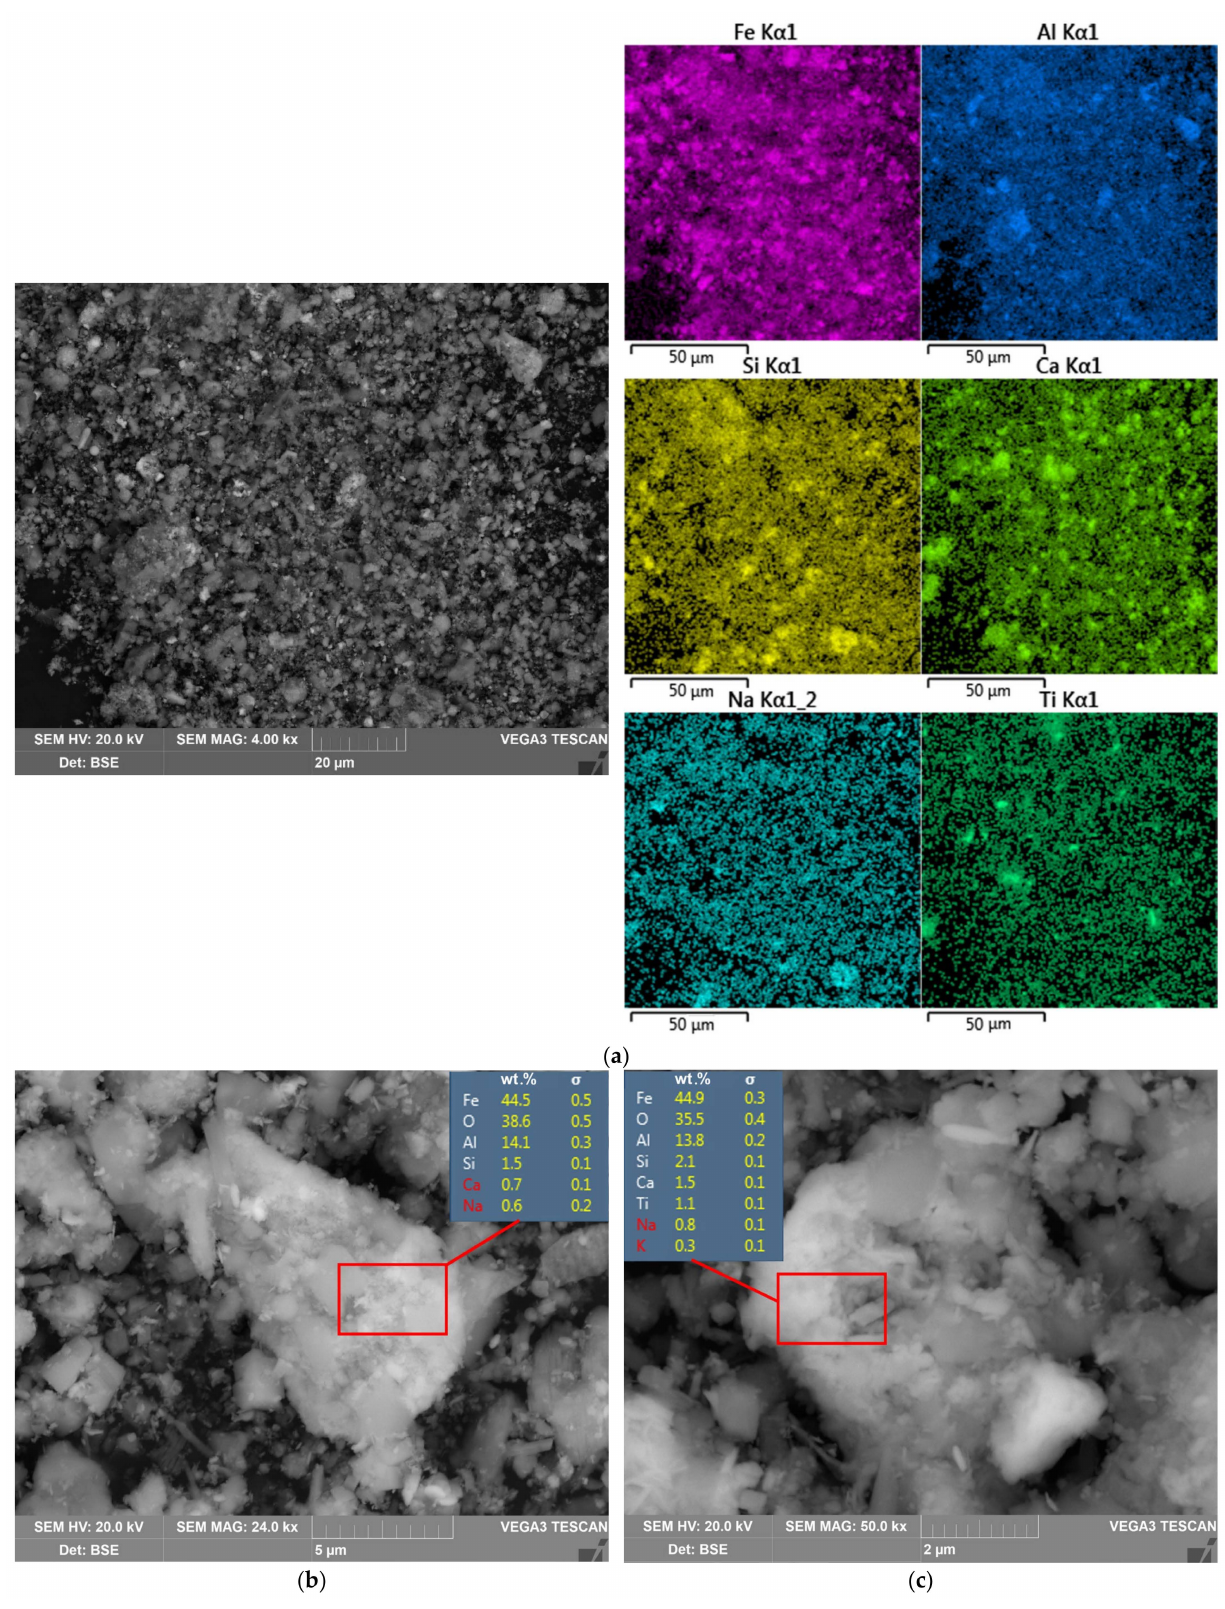
Figure 2. Back-scattered electron (BSE) image of: ( a ) the RM-ESPD surface and elemental distribution of major elements (EDS mapping); ( b ) particles of the RM-ESPD at the magnitude of 24,000 × ; ( c ) particles of the RM-ESPD at the magnitude of 50,000 ×